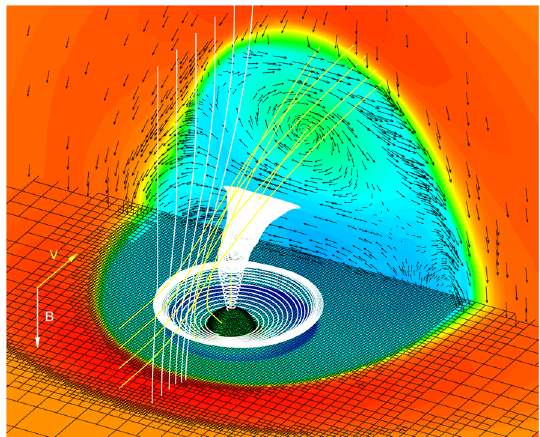
Fig. 14 Three-dimensional view of the global heliosphere. The color code shows the log of plasma density. Yellow lines are the plasma velocity streamlines and the white lines follow the magnetic field lines. Black arrows indicate the direction of the magnetic field along a cross-tail cut placed 225 AU downstream from the Sun. Image reproduced with permission from Linde et al. (1998), copyright by